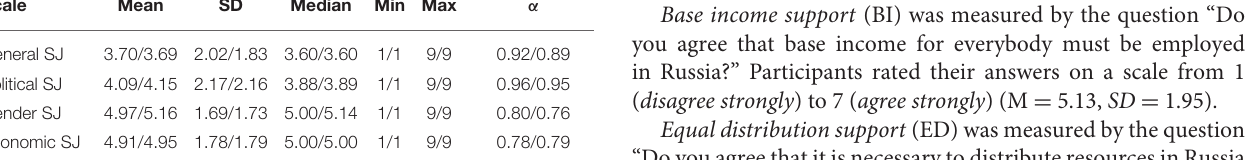
TABLE 4 | Descriptive statistics for SJ scales in Study 2 ( n = 553) and Study 3 ( n = 1,011).